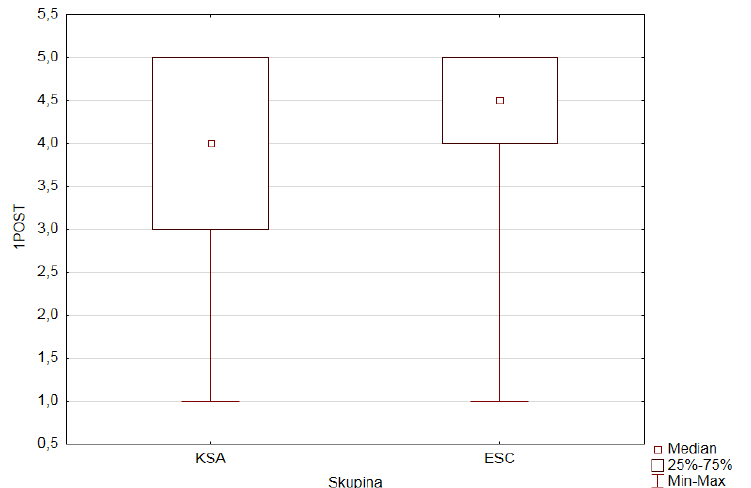
Figure 4. Box graphs of the first item of the posttest - 1POST.